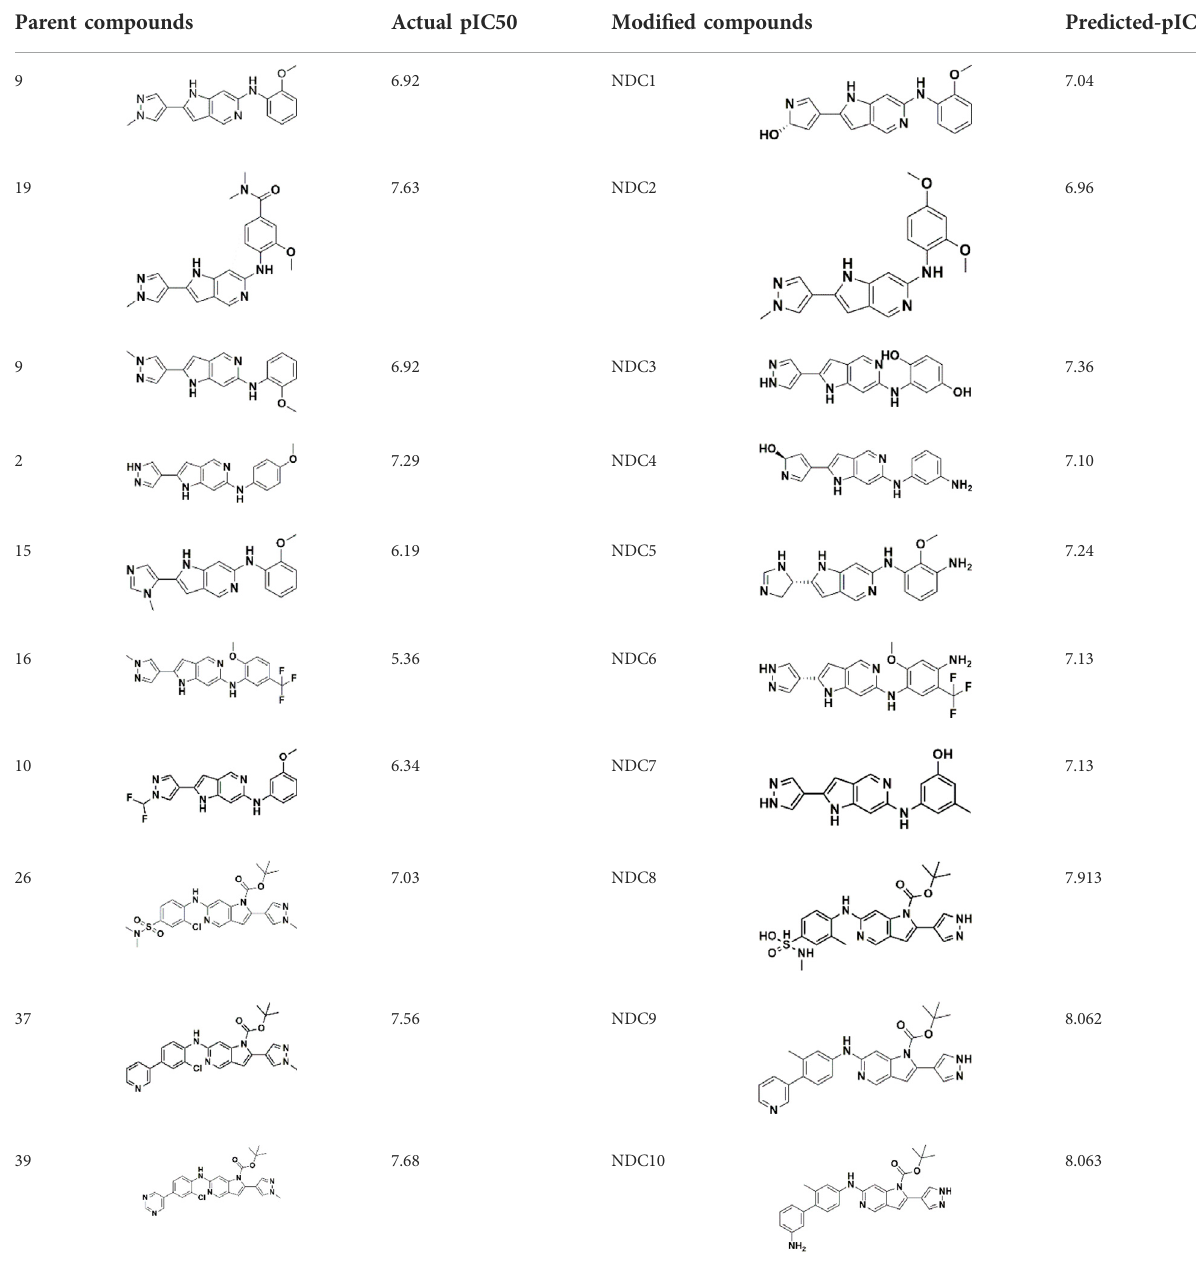
TABLE 2 Comparison of parent and modi fi ed compounds activities. Parent